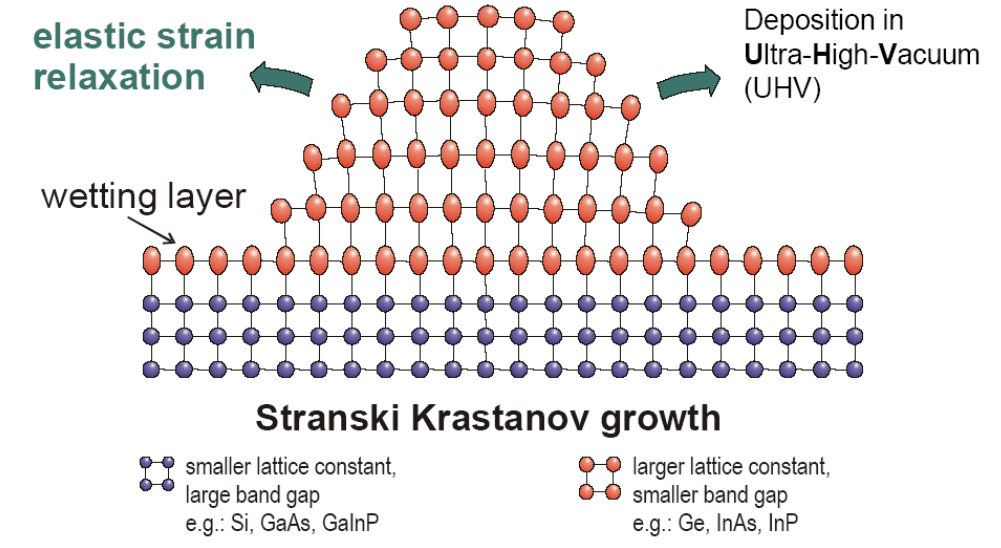
Figure 4. Schema of self-assembled quantum dots growth. Reprinted with permission from